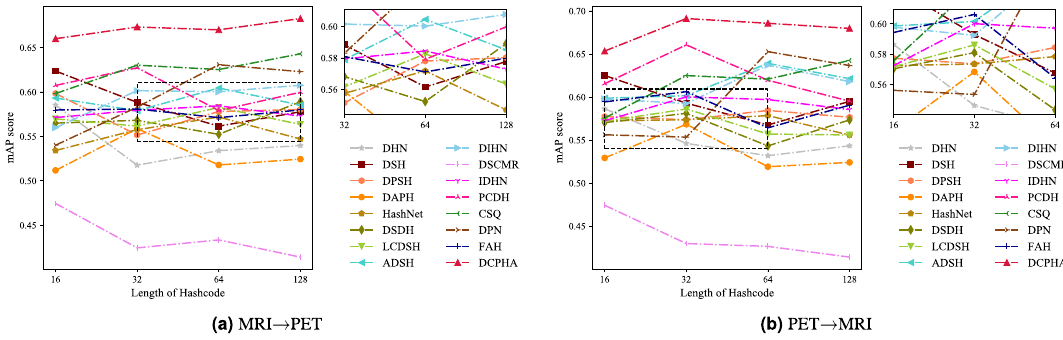
Figure 3. The precision curves of DCPHA and comparisons on ADNI2 dataset.